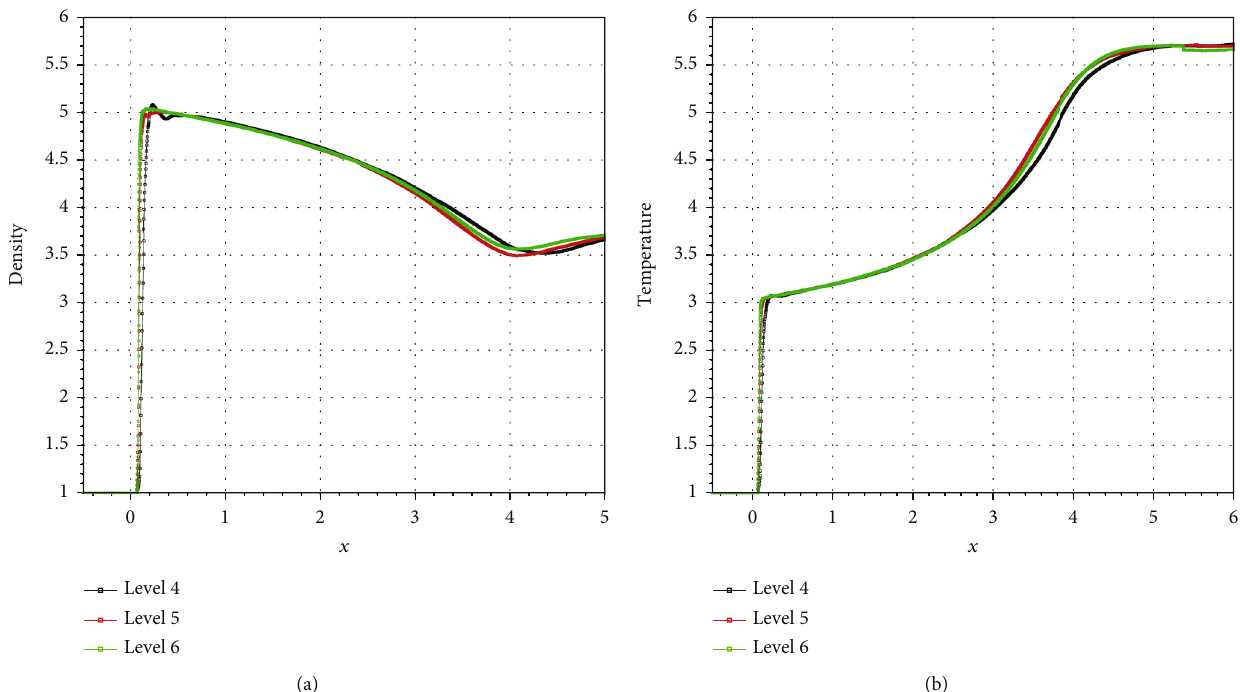
Figure 3: Grid independence study for the higher activation energy case ( E